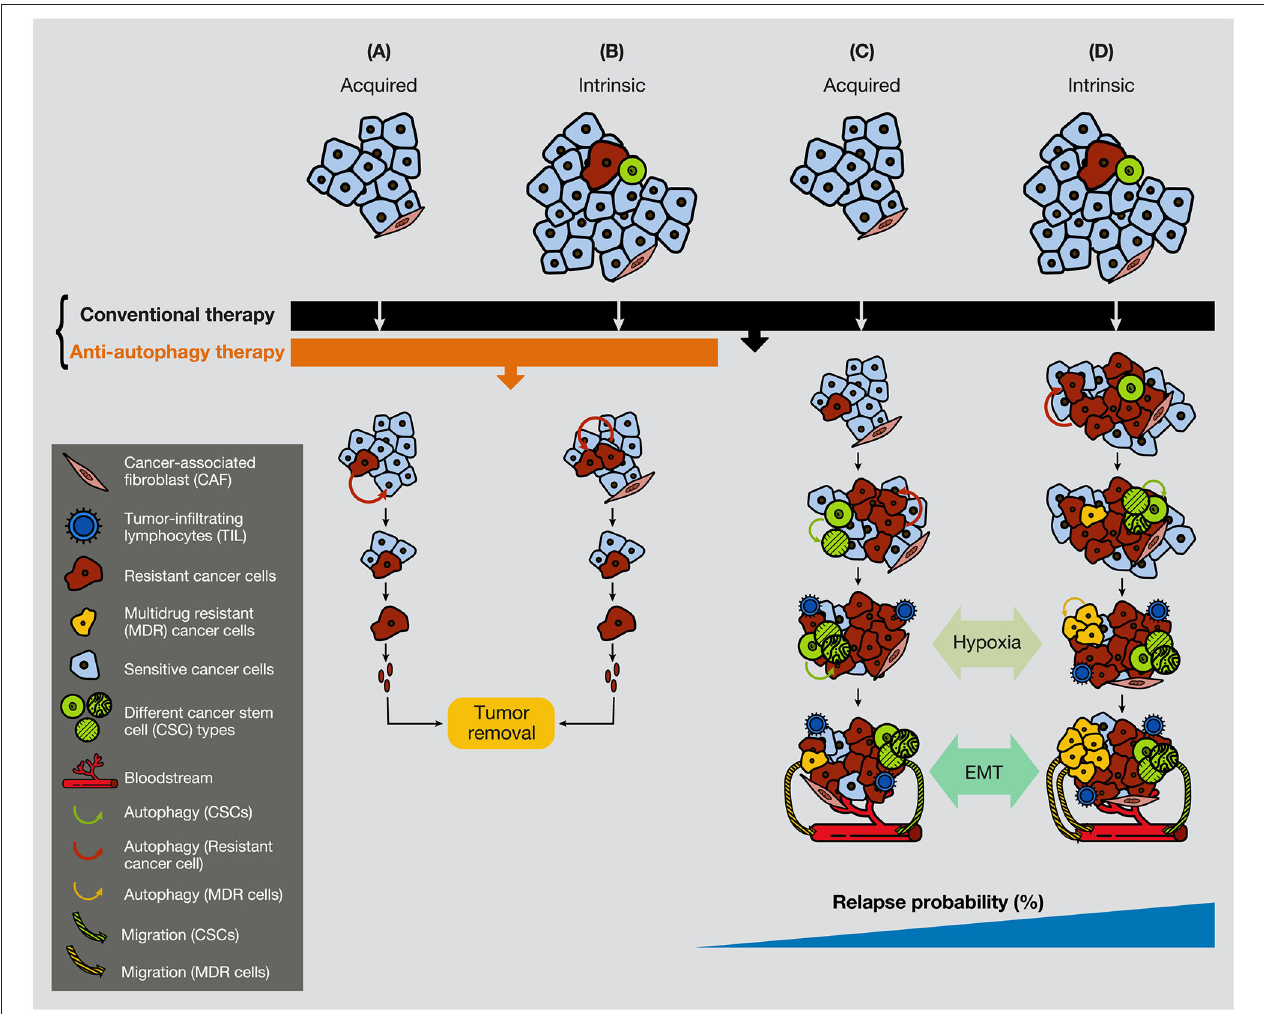
FIGURE 5 | Anti-autophagic therapy can be efficient in the initial stages of tumors in the presence of resistance or CSCs. In the figure are depicted several scenarios where acquired or intrinsic resistance is already present in malignant tumors. (A) Acquired resistance appears consequently to the conventional treatment therapy, but it cannot progress due to the anti-autophagic therapy (e.g., hydroxychloroquine). (B) If resistant cells are present in the tumors, they cannot grow expansively because of the anti-autophagic therapy. (C) Acquired resistance appears consequently to the conventional chemotherapeutic treatment. Resistant cells survive largely supported by the activation of autophagy, either from surrounding cancer cells or from CAFs. (D) While conventional chemotherapeutic treatment annihilates the bulk of cancer cells, it favors the spread of resistant cells, including the CSCs. At a certain time of tumor development, the hypoxic conditions enable EMT process, allowing cancer cell plasticity to enter into the circulation. CAF, cancer-associated fibroblast; TIL, tumor-infiltrating lymphocyte; CC, cancer cell.